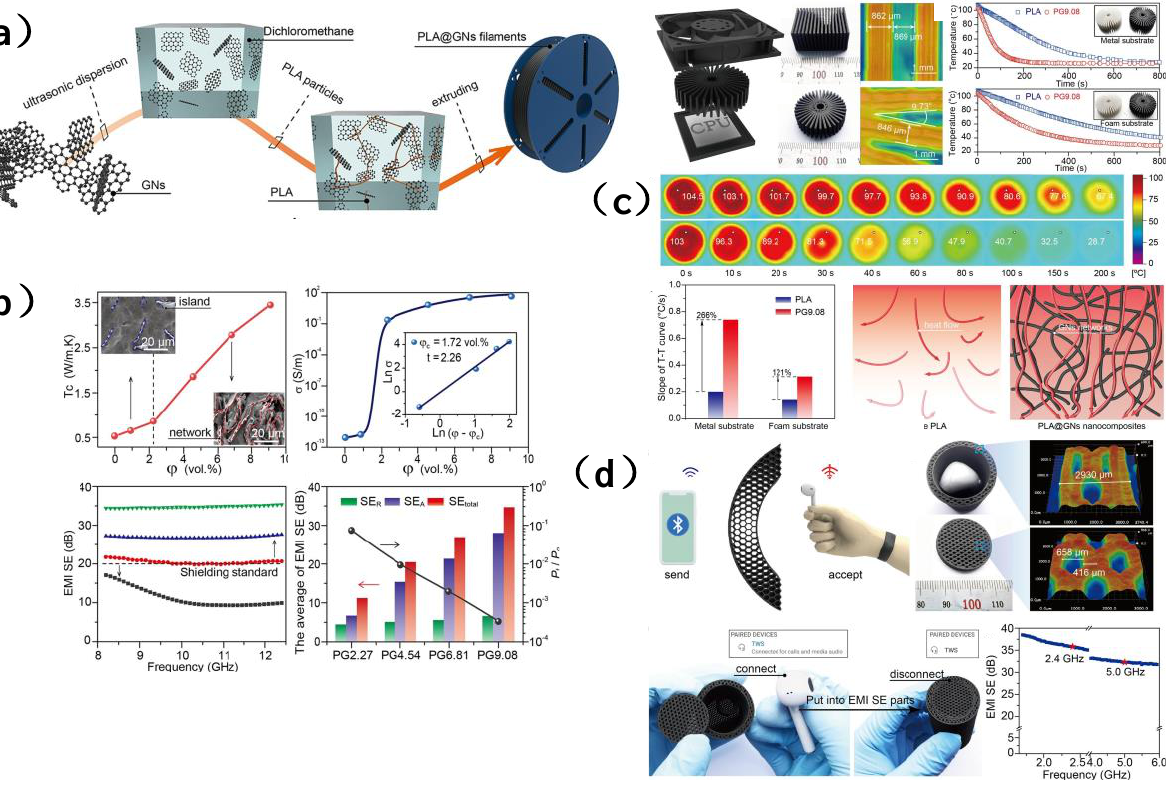
Figure 13. ( a ) Schematic diagram of the preparation process leading to PLA@GNS filament. ( b ) a − b: thermal conductivity and electrical conductivity of PLA@GNS nanocomposites, c: EMI SE